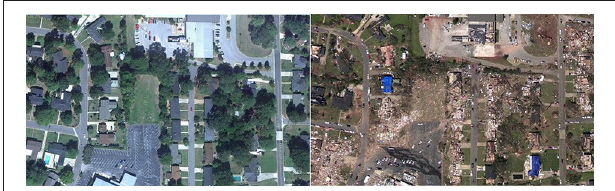
FIGURE 8 | Before-and-after imagery of neighborhood in Tuscaloosa, AL, struck by tornado on April 27, 2011. Left image credit: Google Earth. Right image: 25-cm aerial imagery. Image credit: NOAA (public